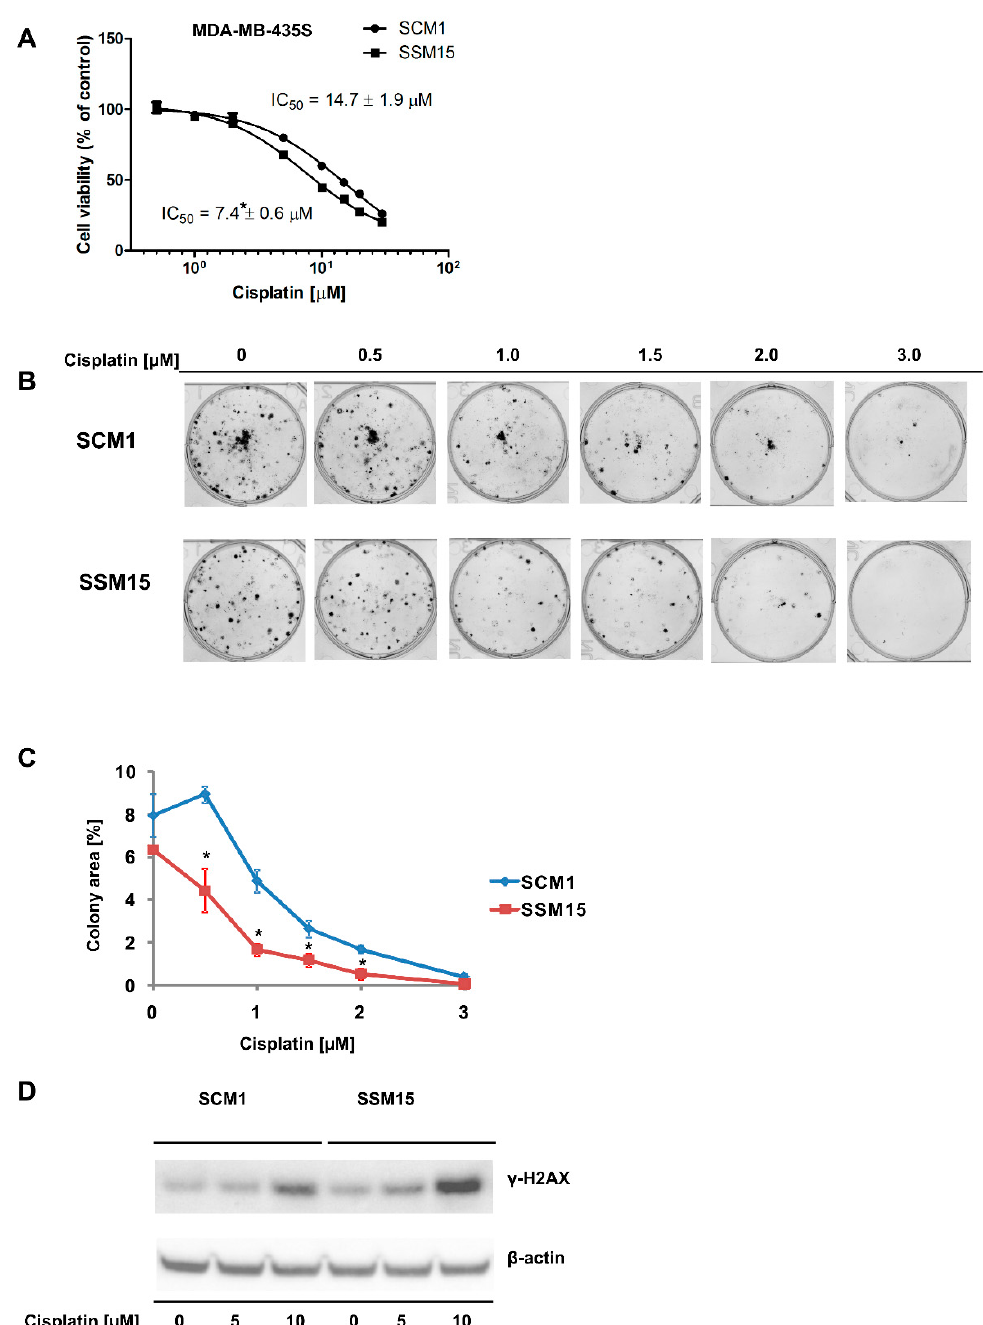
Figure 1. shRNA-mediated downregulation of SIRT2 sensitizes melanoma cells to cisplatin. ( A ) The effects of cisplatin treatment (96 h) on the viability of melanoma SCM1 and SSM15 clones of the MDA-MB-435S cell line were evaluated using the neutral red assay. The results are shown as the mean ± standard deviation ( n = 3, independent experiments). ( B ) Results of the colony formation assay performed on melanoma SCM1 and SSM15 clones of the MDA-MB-435S cell line exposed to different cisplatin concentrations. Images from a single representative experiment are shown. ( C ) A colony area values from the colony forming assay shown as the mean ± standard deviation ( n = 3, independent experiments). * Indicates a statistically significant difference at p < 0.05. ( D ) Effect of cisplatin on the accumulation of γ -H2AX in melanoma SCM1 and SSM15 clones of the MDA-MB-435S cell line. Cells were treated with cisplatin for 48 h. Then, cells were harvested and protein lysates were prepared and analyzed by Western